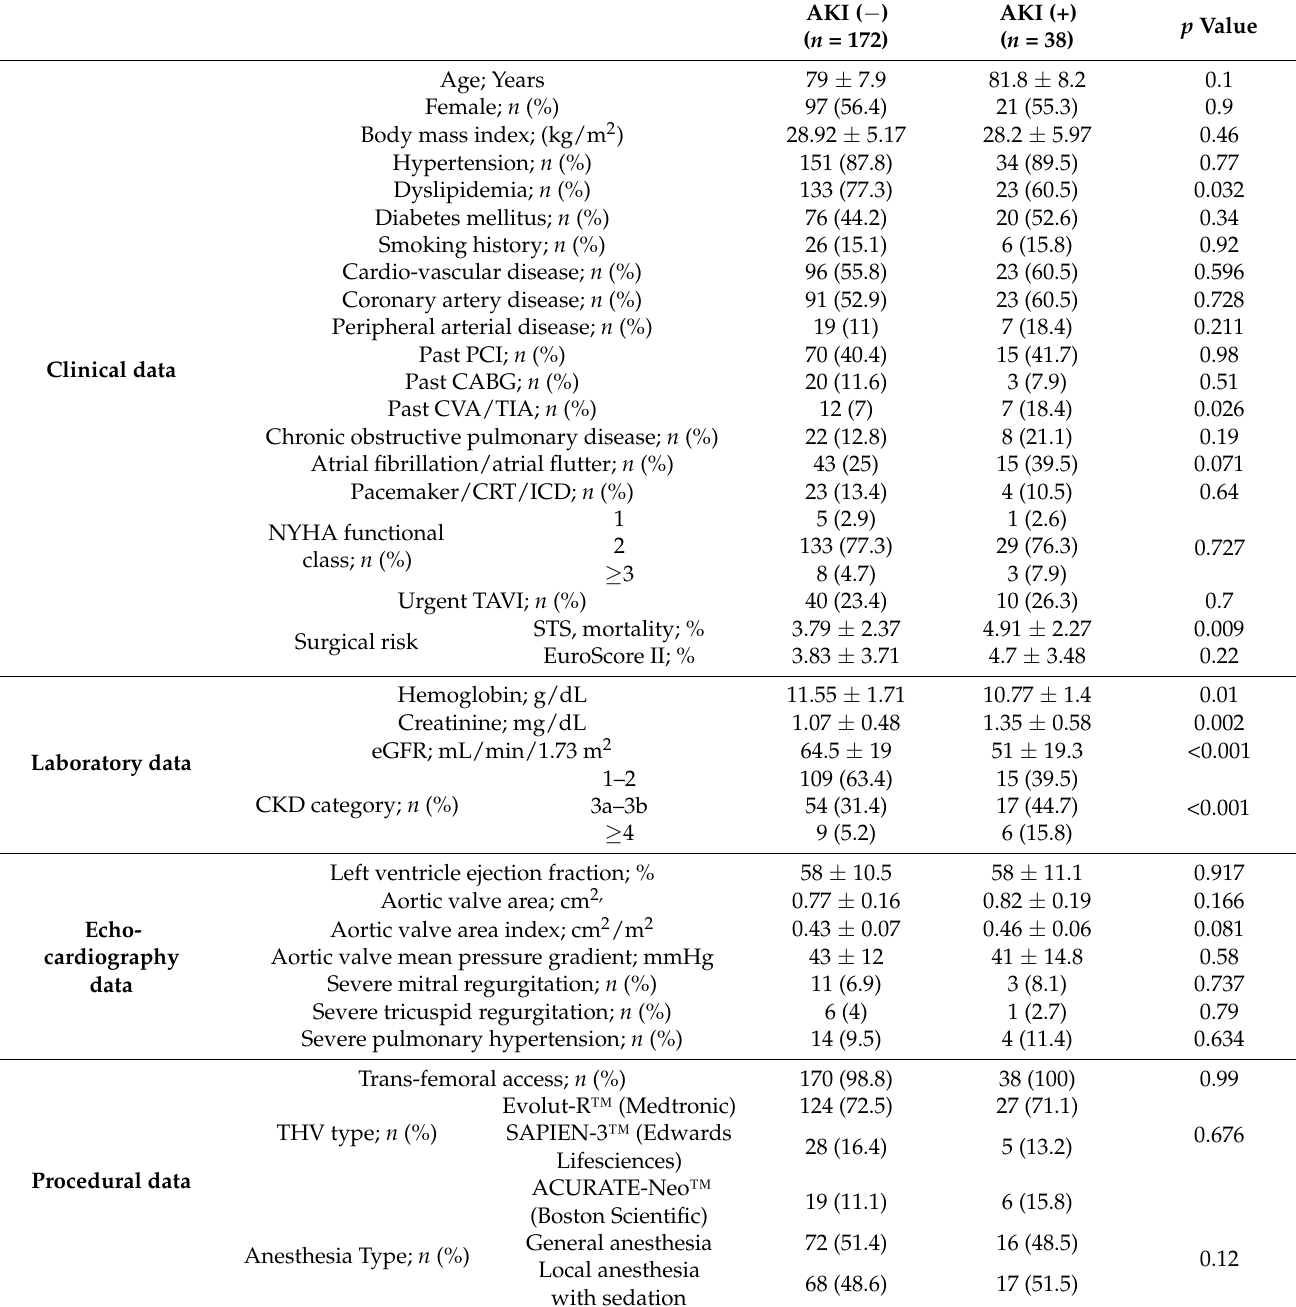
Table 1. Baseline